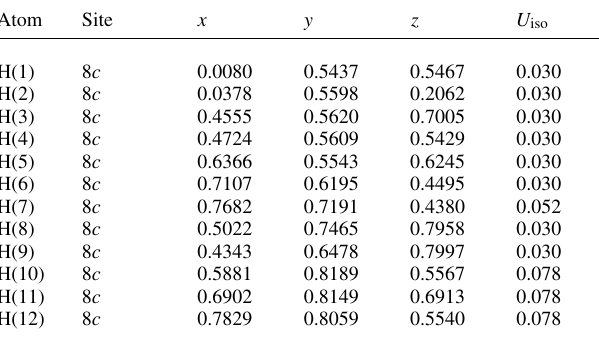
Table 2. Atomic coordinates and displacement parameters (in Å 2 )